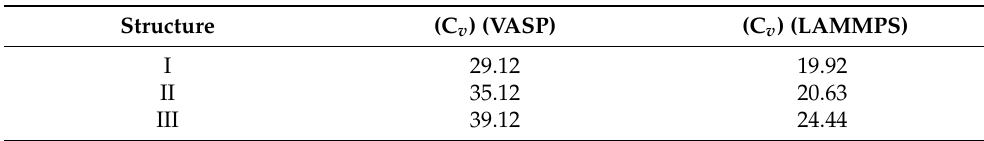
Table 3. Specific heat capacity (C v ) at 800 K calculated using equation Equation (1) for VASP and LAMMPS simulations (values are given in J/K/ mol).